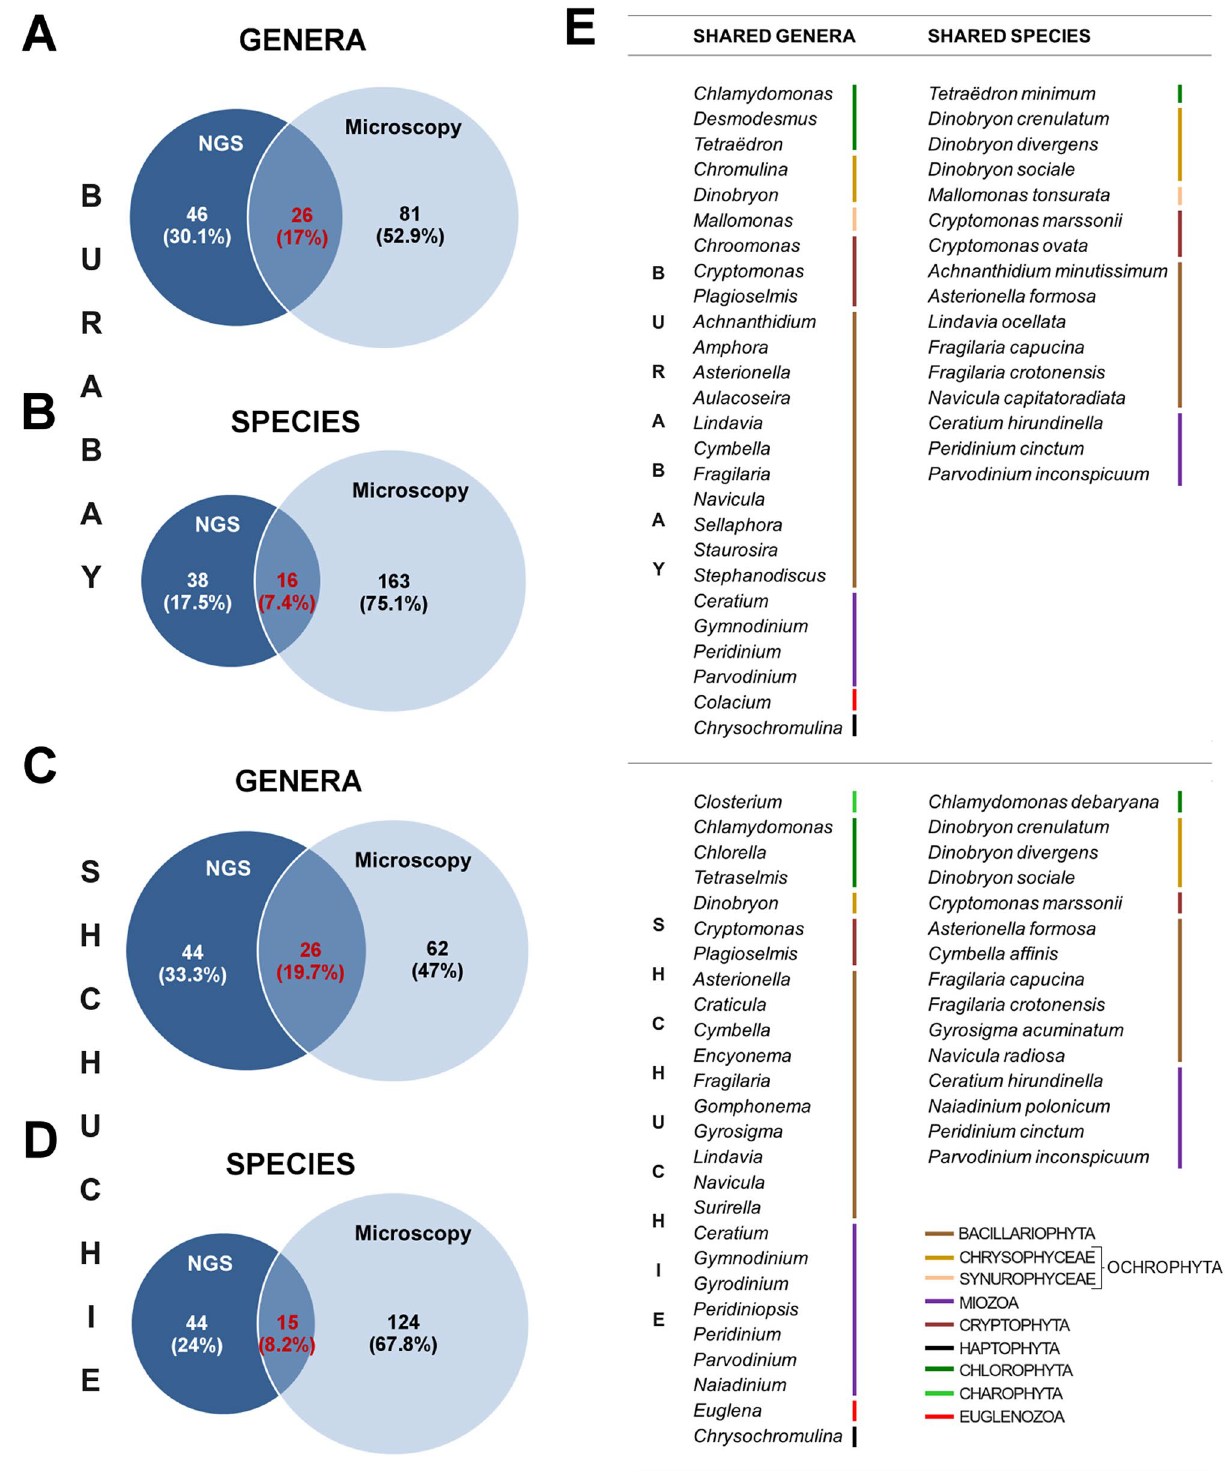
Figure 5. Shared genera and species for eukaryotic phytoplankton of Lakes Burabay and Shchuchie detected by microscopy approach and next-generation sequencing of 18S rRNA gene. Venn diagrams for similar and unique genera (( A )—Lake Burabay, ( C )—Lake Shchuchie) and species (( B )—Lake Burabay, ( D )—Lake Shchuchie) detected by microscopy and NGS. ( E )—complete list of shared genera and species for phytoplankton of both